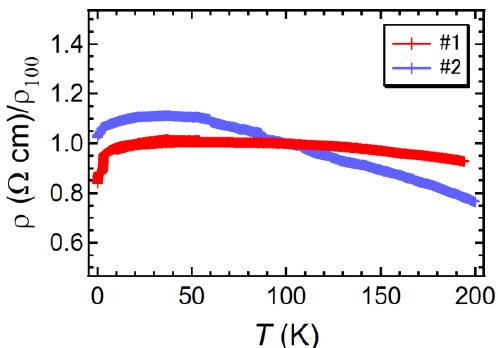
Figure 4. The temperature dependence of the electric resistivity of Li 0.8 WO 3 normalized for the 100 K value. #1 and #2 are the batch numbers. ρ 100 = 4.4 (#1) and 11 (#2) × 10 −2 Ω cm.